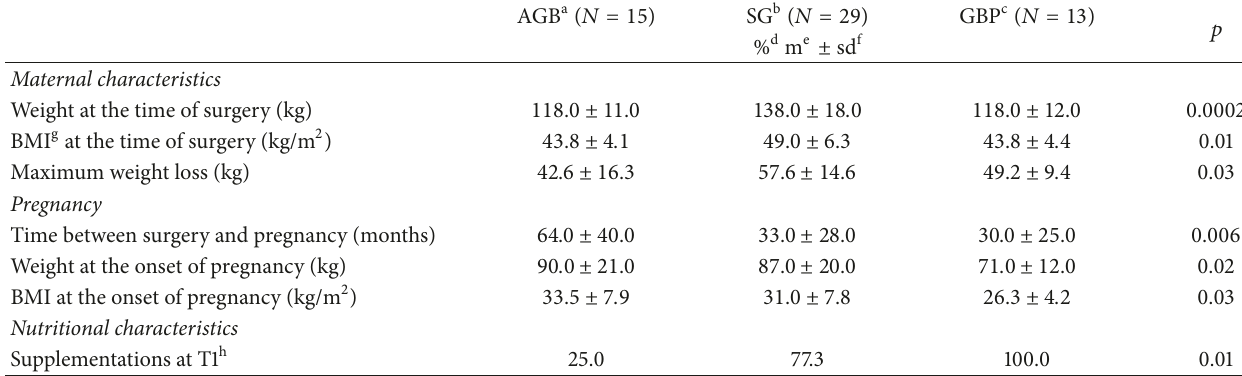
Table 5: Maternal, nutritional, and pregnancy-related characteristic according to surgical technique.